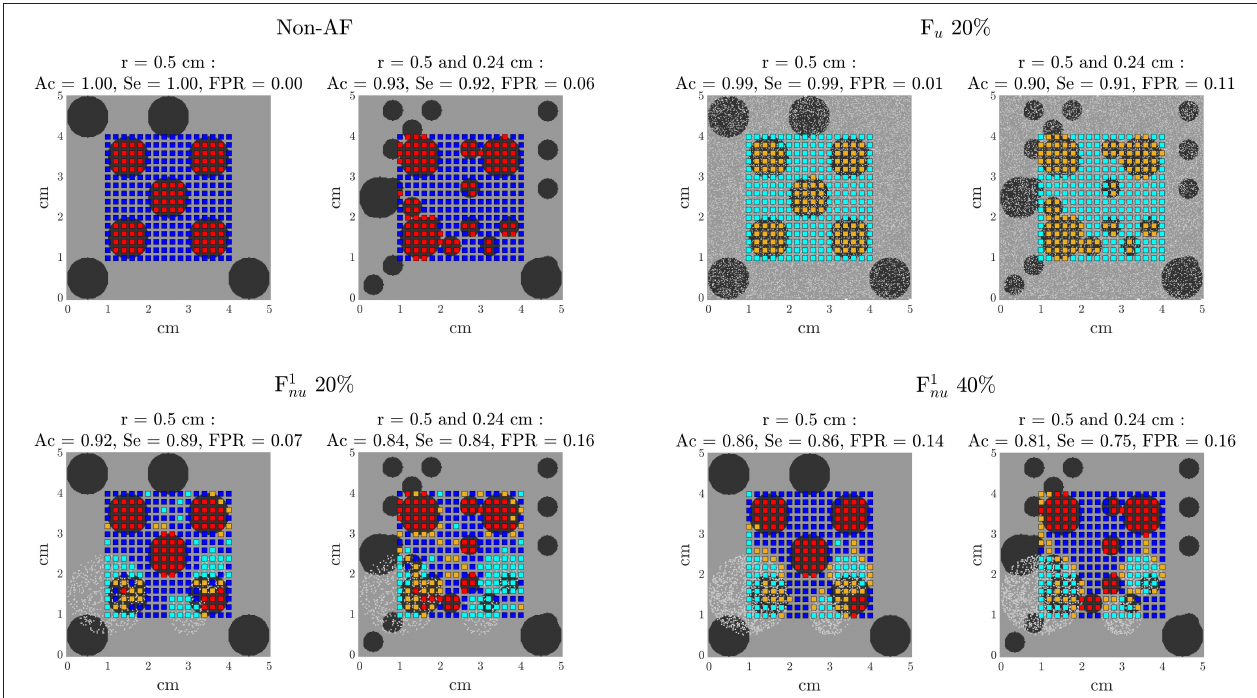
FIGURE 9 | Results of the algorithm for detection of ACh release sites. Each electrode is assigned with non-ACh, ACh, non-ACh + fibro, or ACh + fibro on the basis of EGM analysis. The color code is the same as in Figures 5 , 6 .